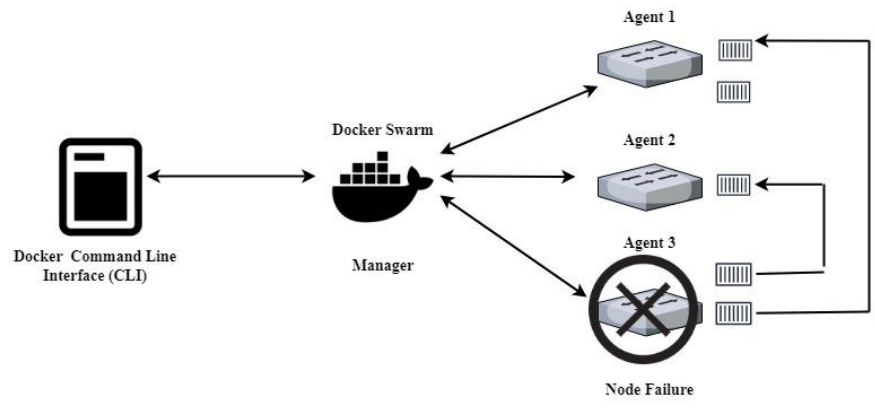
Figure 10. Docker swarm network – failure